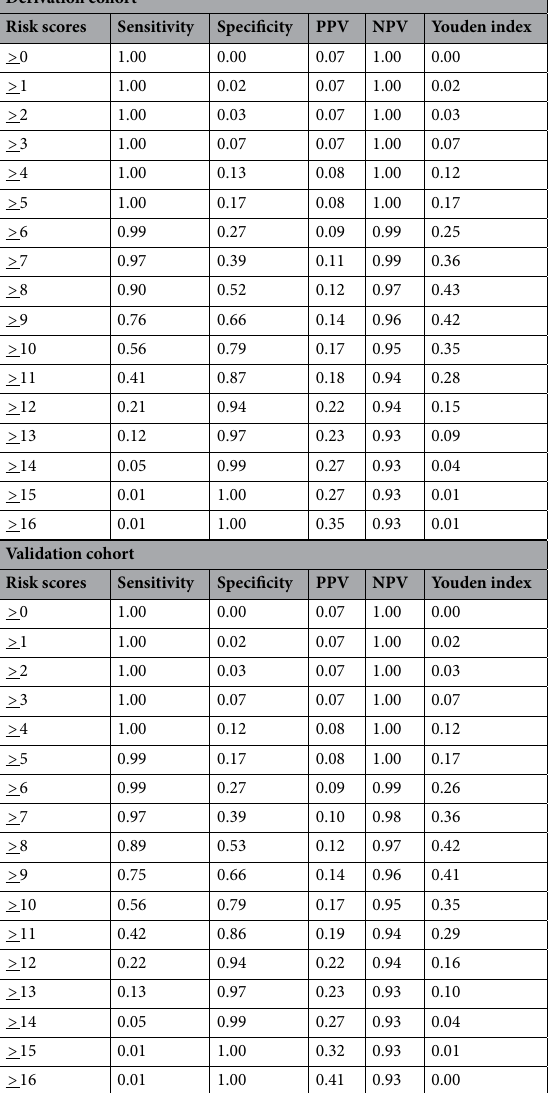
Table 4. Predictive performance of the developed 5-year CKD risk score. Predictive performance of the developed 5-year CKD risk score in derivation and validation. PPV positive predictive value, NPV negative predictive